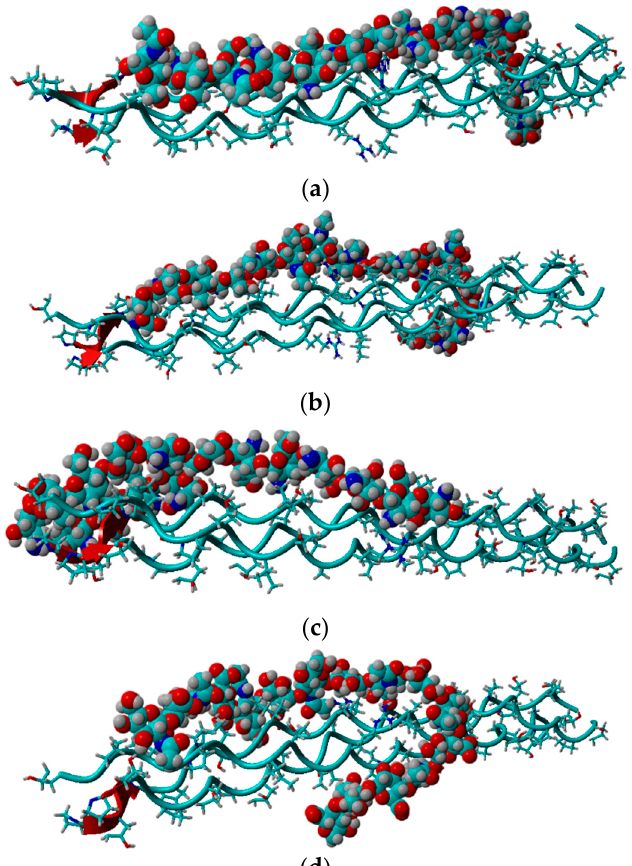
Figure 2. Snapshot from docking experiment showing optimized complexes for ( a ) DD = 12.5%, ( b ) DD = 50%, ( c ) DD = 100%, ( d ) HA.